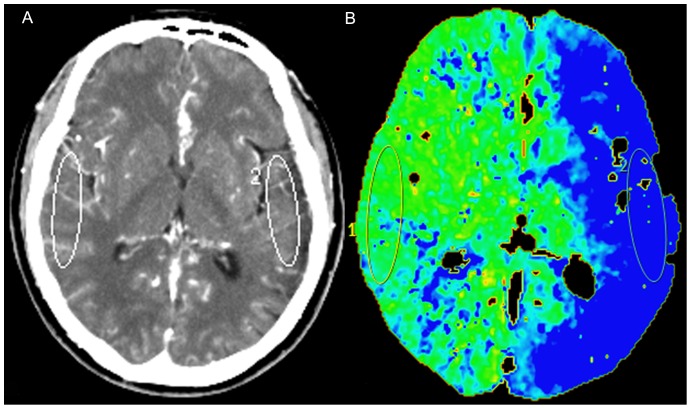
Regions of interest (ROIs) were placed on cortical regions in the middle cerebral artery territory.ROIs were drew in (A) the reference CT image, and (B) vessel-removed mean transit time (MTT) map.